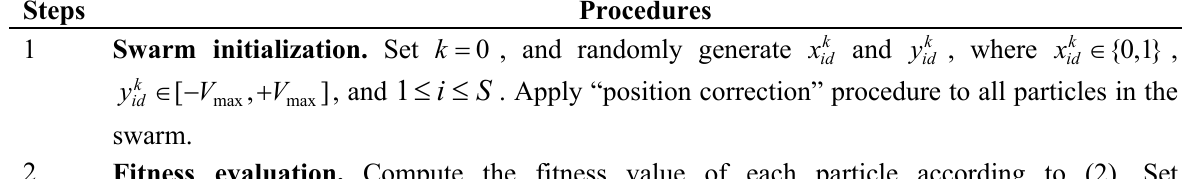
Table 2. Proposed algorithm for target channel visiting